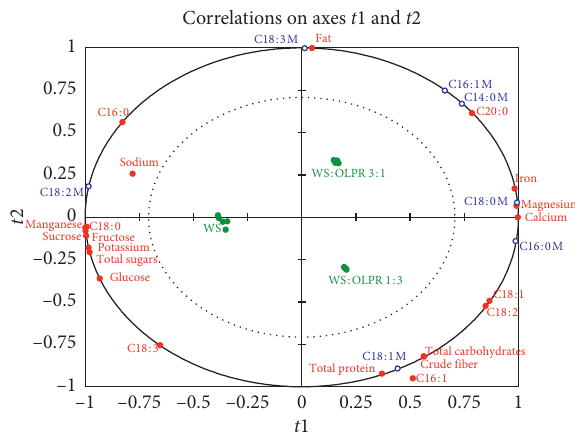
Figure 3: Correlations between mushroom fatty acids and